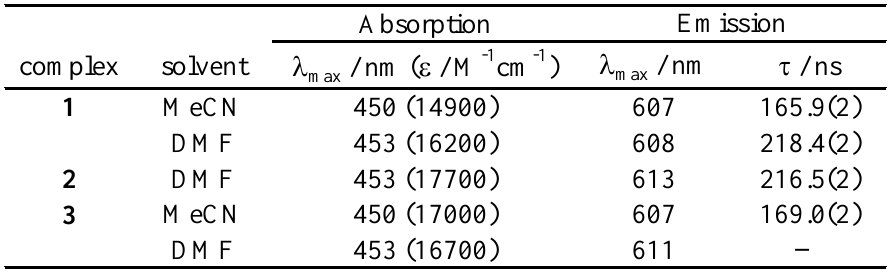
Table 1. Absorption and emission properties of 1 - 3 .